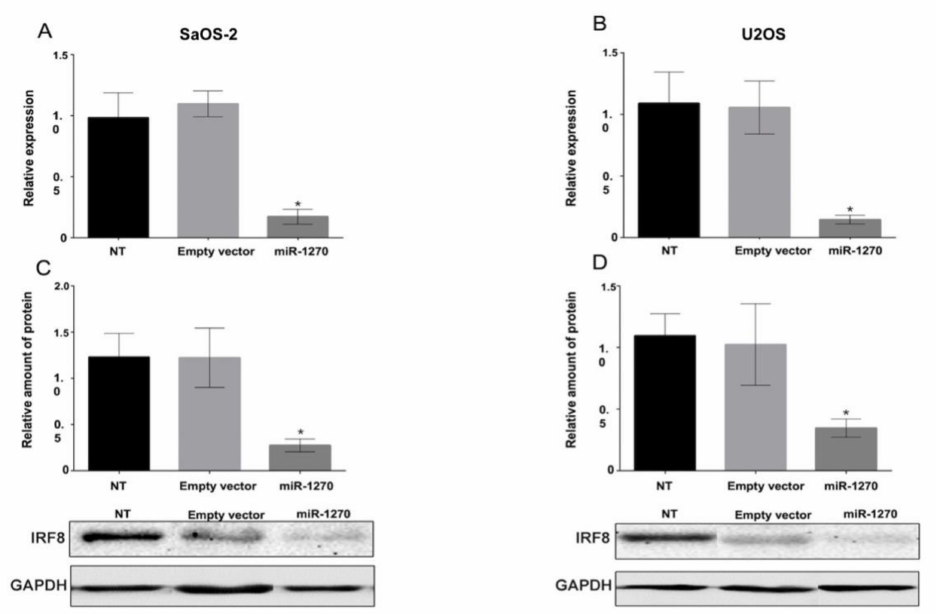
Figure 2. MicroRNA-1270 overexpression reduces the mRNA and protein expression levels of IRF8. Reverse transcription-quantitative PCR analysis was carried out to determine the mRNA expression levels of IRF8 in ( A ) SaOS-2 and ( B ) U2OS cells using SYBR Green technology. GAPDH was used as a reference gene. Densitometric analysis of IRF8 protein expression levels in transfected and non-transfected ( C ) SaOS-2 and ( D ) U2OS cells is shown. Data are expressed as the mean ± SD from three independent experiments. Non-parametric Mann–Whitney U test was performed. * p < 0.05. IRF8, interferon regulatory factor